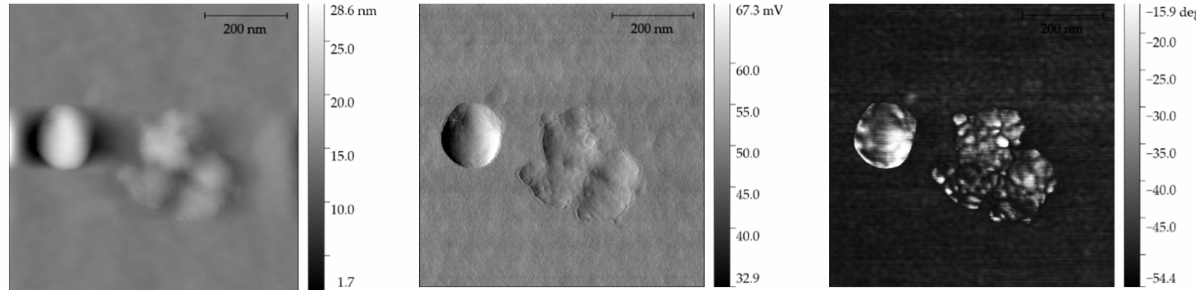
Figure 7. AFM images: height, signal error and phase signal. Visible zirconium oxide grain and coating material.